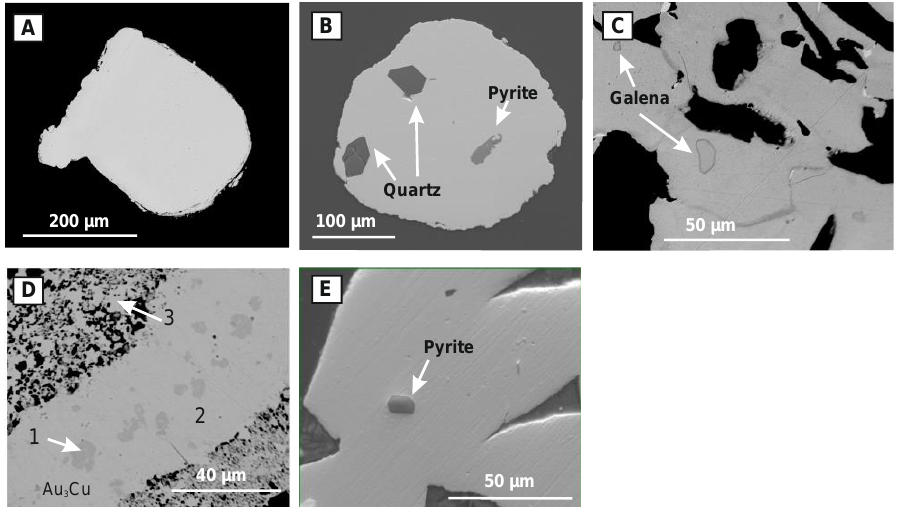
Figure 6. Internal compositional characteristics of gold revealed by SEM imaging. ( A ) An example BSE image of homogenous, inclusion-free gold particle (Glen Quaich); ( B ) Homogenous alloy, con- taining inclusions of quartz and pyrite (Calliachar Burn); ( C ) Films of Ag-rich Au alloy (dark grey) and Ag-poor Au alloy(very light grey) in a gold particle containing galena inclusions (Glen Quaich); ( D ) Compositional heterogeneity within agold particle containing Pd as an alloy component, (Glen Lednock); 1: Au: 87.4%, Cu: 8.4%, Pd: 4.3%, 2: Au: 91.8%, Ag: 0.2%, Cu: 1.3%, Hg: 0.6%, Pd: 5.6%, 3: Au: 95.1%, Cu: 1.5%, Pd: 3.4% (all wt%); ( E ) example of typical small pyrite inclusion found in gold from localities of Group 1.